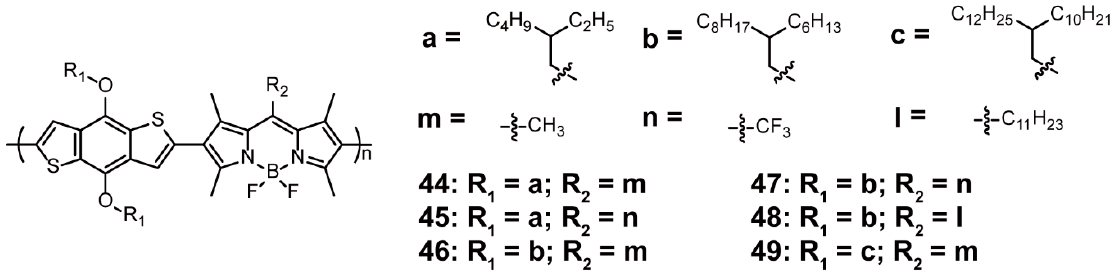
Figure 15. Chemical structures of polymers 44 – 49 (Reproduced with permission from Reference [81]. Copyright @ 2018, American Chemical Society).